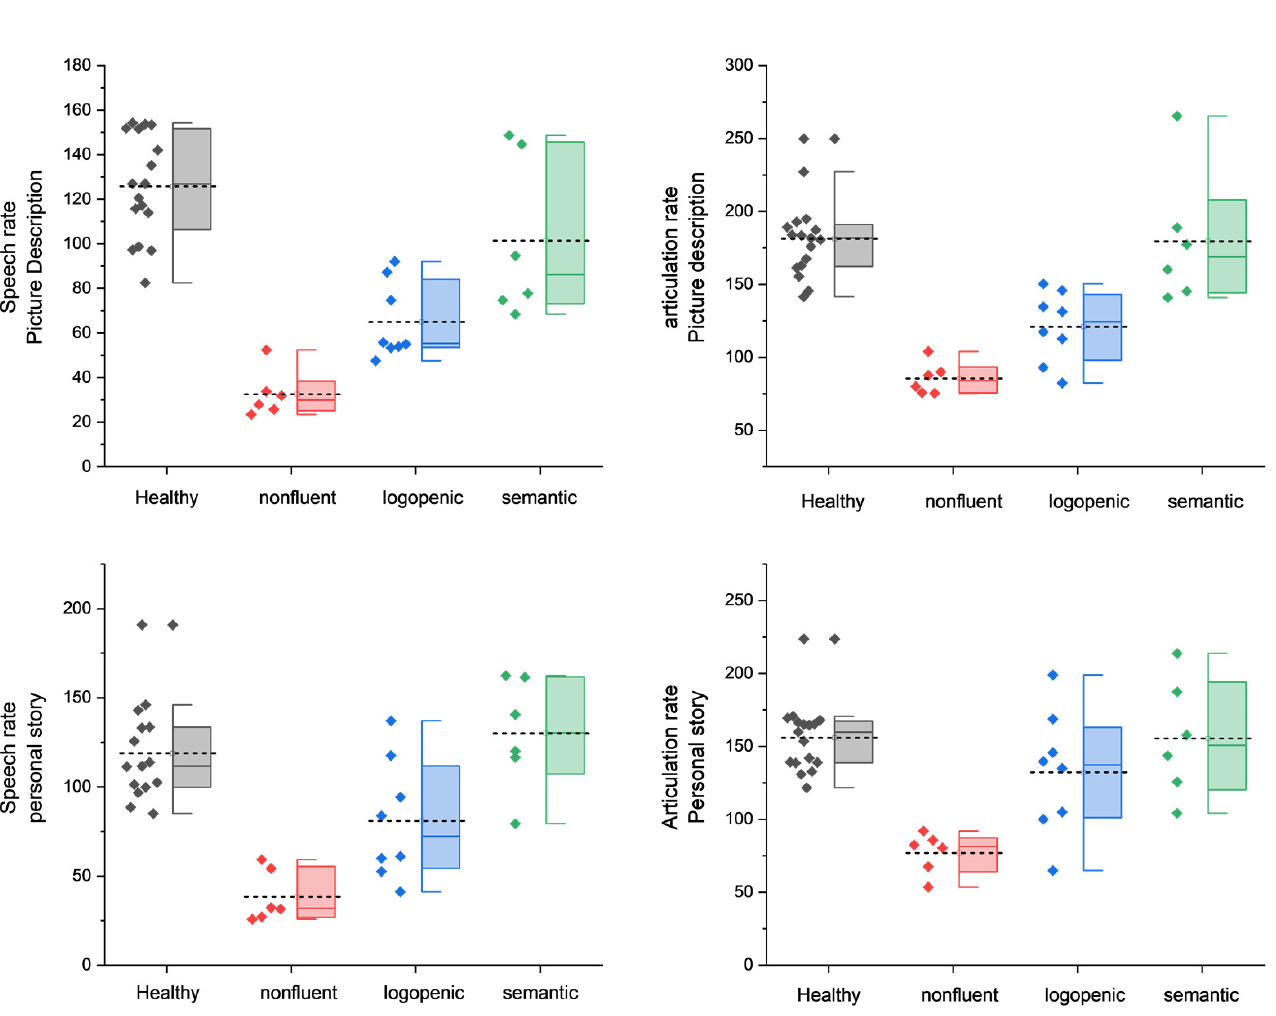
Figure 2. Box plots of speech rate and articulation data for each type of diagnosis. First row: picture description task. Second row: personal story narration. Each box has a range of 25–75, the whiskers indicate the range of the outliers, the colored line inside each box is the median, and the short dashed lines are the mean.